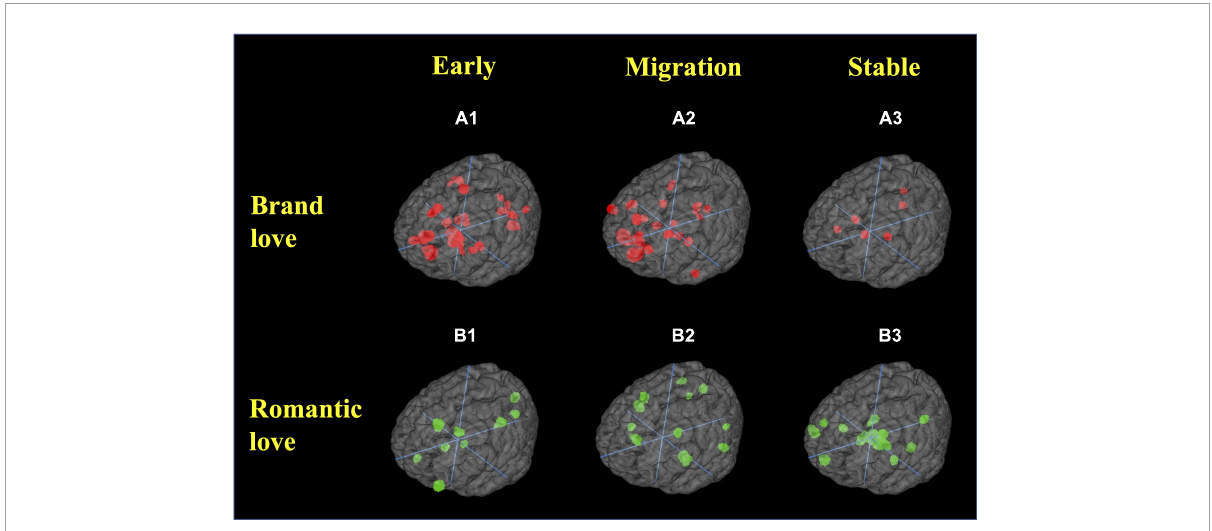
FIGURE6 Region of interest. (A) Brand love relationships; (A1) early stage; (A2) migration stage; (A3) stable stage. (B) Interpersonal romantic love relationships; (B1) early stage; (B2) migration stage; (B3) stable stage. All crosshairs =